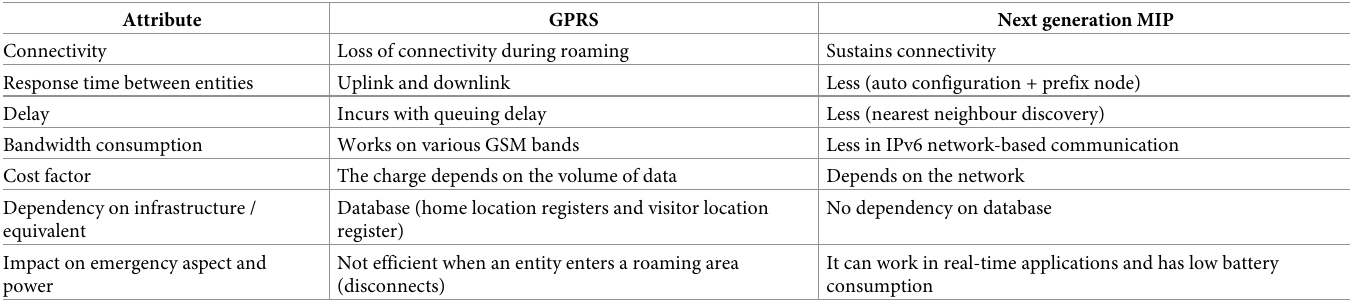
Table 4. Comparison of GPRS and IPv6 based